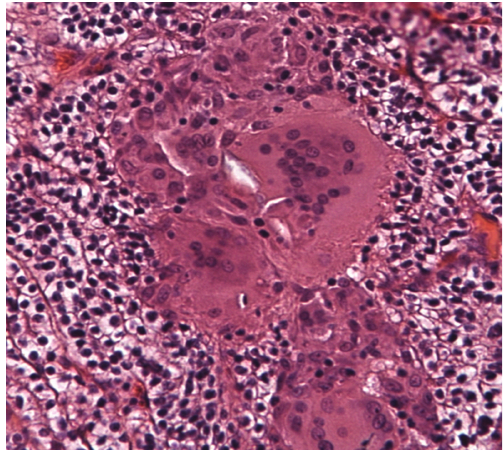
Figure 3: Epithelioid nonnecrotizing granulomas with multinucle- ated foreign body type giant cells (200x